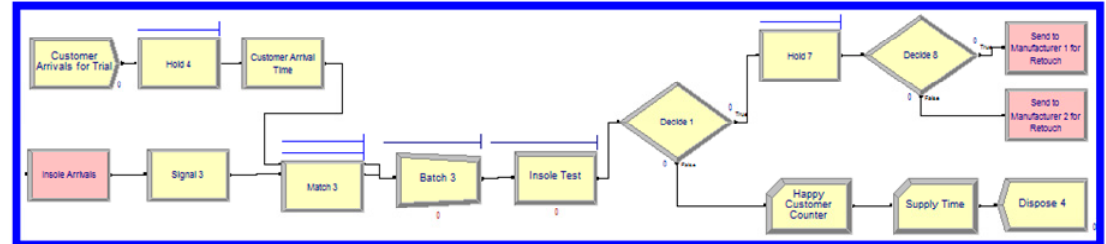
Figure 9. Assembling of cork, plastic and leather in manufacturers.